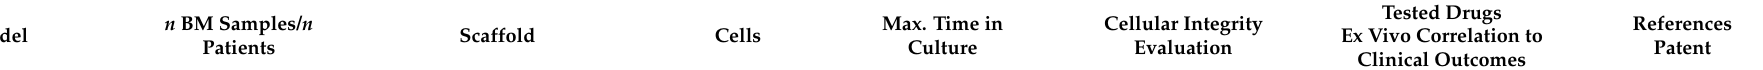
Table 1. Available 3D patient-derived MM models. n of BM samples, number of samples obtained from patient biopsy and used for cell culture in the 3D model; n of patients, number of patients who entered a study of correlation of the obtained laboratory results in 3D culture versus clinical outcome. Abbreviations: BM, bone marrow; BMMC, bone marrow mononuclear cells; BMSC, bone marrow stromal cells; CaCl 2 , calcium chloride; CFSE, carboxy fluorescein succinimidyl ester; CFU, colony-forming unit; ECM, extracellular matrix; FISH, fluorescence in situ hybridization; GelMA, gelatin methacryloyl; HARV, high-aspect-ratio vessel; HUVEC, human umbilical vein endothelial cells; IHC, immunohistochemistry; iPSC, induced pluripotent stem cells; me-HA, methacrylated hyaluronic acid; MM, multiple myeloma; MSC, mesenchymal stem cells; nHA, nanohydroxyapatite; PBMC, peripheral blood mononuclear cells; PDMS, polydimethylsiloxane; PI, proteasome inhibitors; rBM, reconstructed bone